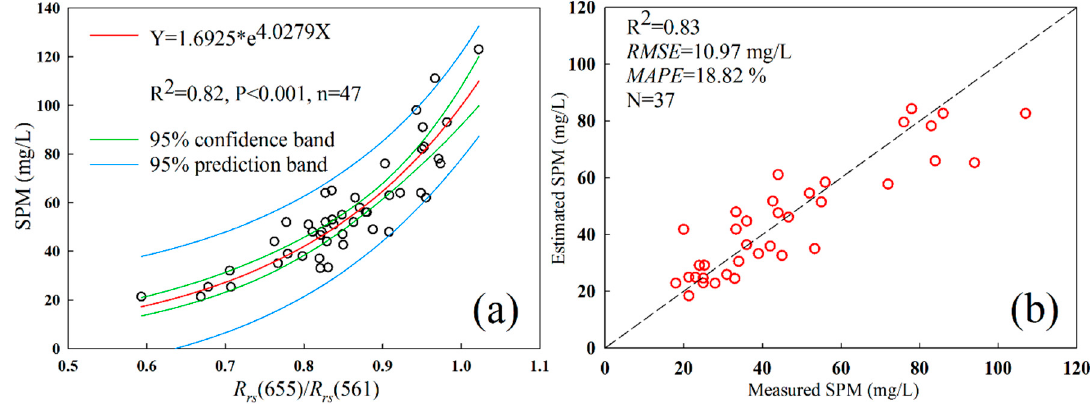
Figure 8. Scatter plots of SPM calibration between in situ measurement data and SPM model ( a ), validation between measured and simulated R rs -based derived measurements ( b ).